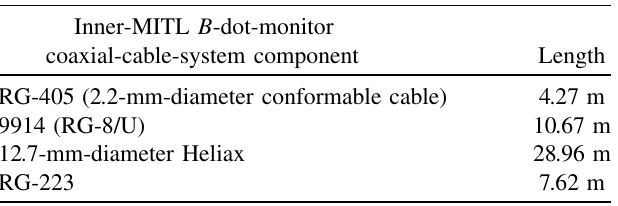
TABLE II. Components of the coaxial-cable system used by an inner-MITL B -dot current monitor. The RG-405 cable con- nects to the monitor; the RG-223 cable connects to a transient- waveform-digitizing oscilloscope, which is located inside a double-wall screen room.